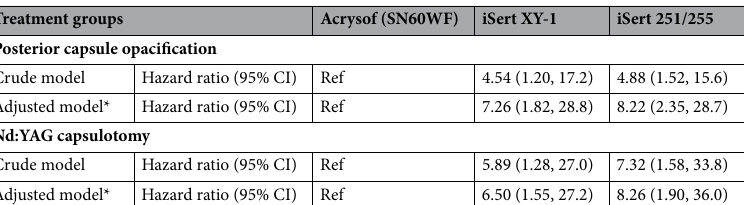
Table 3. Hazard ratios of posterior capsule opacification and Nd:YAG capsulotomy, comparing the iSert XY-1 and iSert 251/255 as the index group with the Acrysof (SN60WF) as the reference group using data over the 5-year follow-up period. Variables included as covariates in the adjusted model were age, sex, diabetes mellitus, and sarcoidosis. The Acrysof IOL (SN60WF) was defined as the reference group and the iSert (XY1 or 251/255) group as the index group. CI confidence interval, Ref.